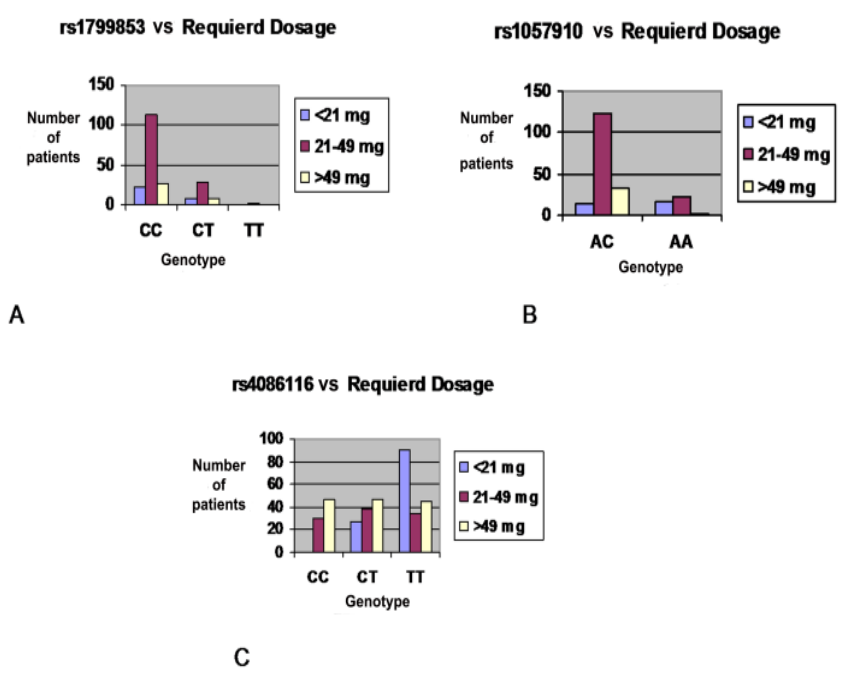
Figure 2. The distribution of warfarin dose by CYP2C9 genotypes during the initiation phase of therapy for 212 Jordanian cardiovascular patients: X axis represents different CYP2C9 genotypes, Y axis represents the proportion of patients across each genotype, Blue column represents a sensitive group who required the lowest warfarin dose (<21 mg/week), Purple column represents the intermediate group who required moderate warfarin dose ((21–49) mg/week), Yellow column represents a resistant group who required the highest warfarin dose (>49 mg/week). ( A ) Distribution of warfarin dose by rs1799853 variant. ( B ) Distribution of warfarin dose by rs1057910 variant. ( C ) Distribution of warfarin dose by rs4086116 variant.